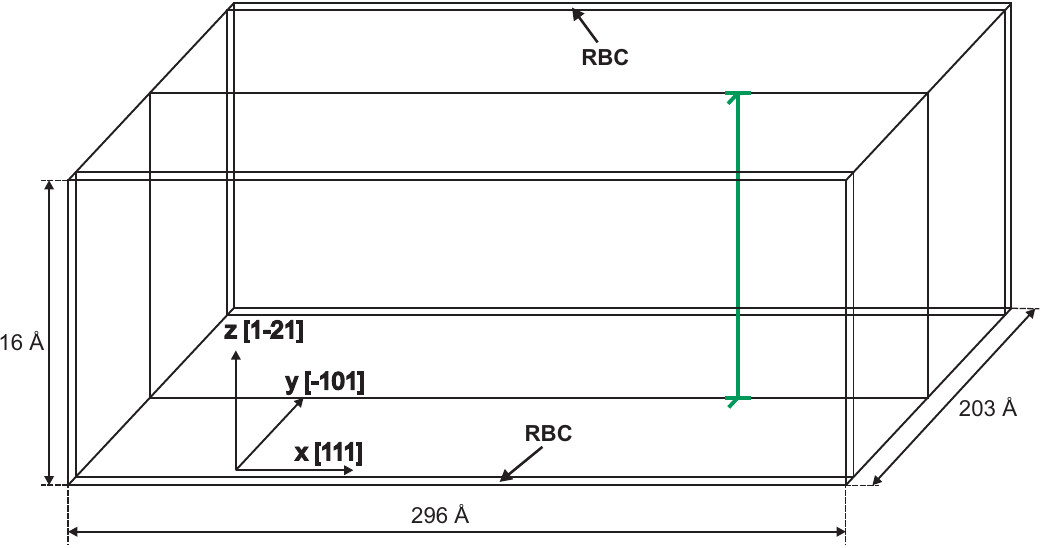
Figure 2. Simulation box containing a single 1/2 [ 111 ]( ¯101 ) edge dislocation (green line). Periodic boundary conditions were used along [ 1 ¯2 1 ] ( x ) and [ 111 ] ( z ) directions, whereas rigid boundary conditions were applied along the [ ¯101 ] ( y )